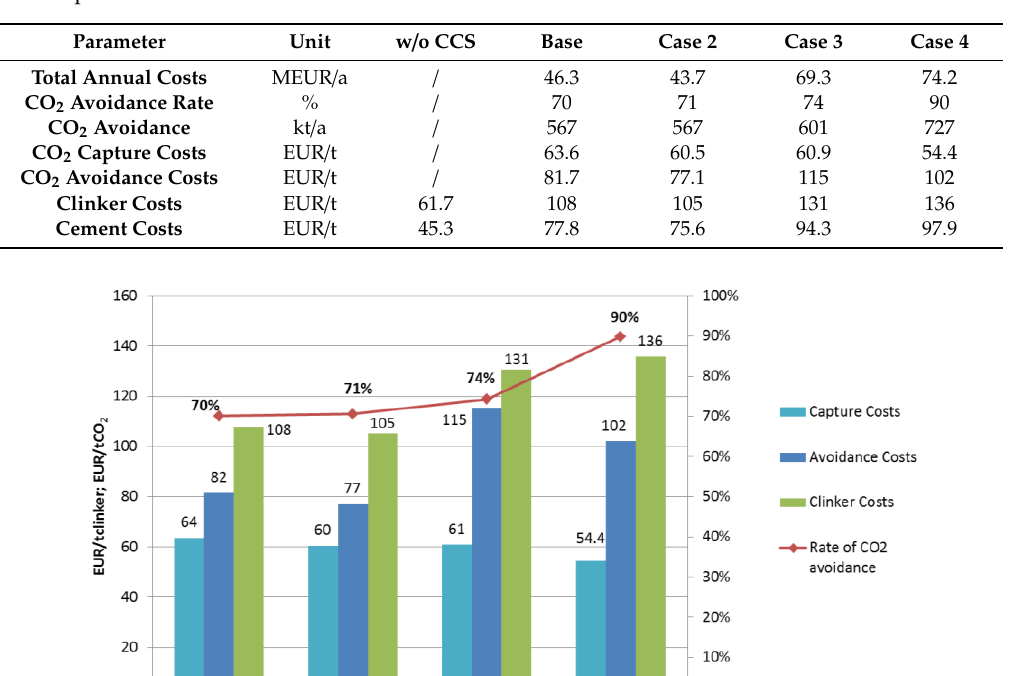
Figure 2. Purchased equipment costs for carbon capture in cement plants. Table 6. Annual costs, CO 2 captured, and avoidance mass and costs, clinker costs for carbon capture in cement plants.